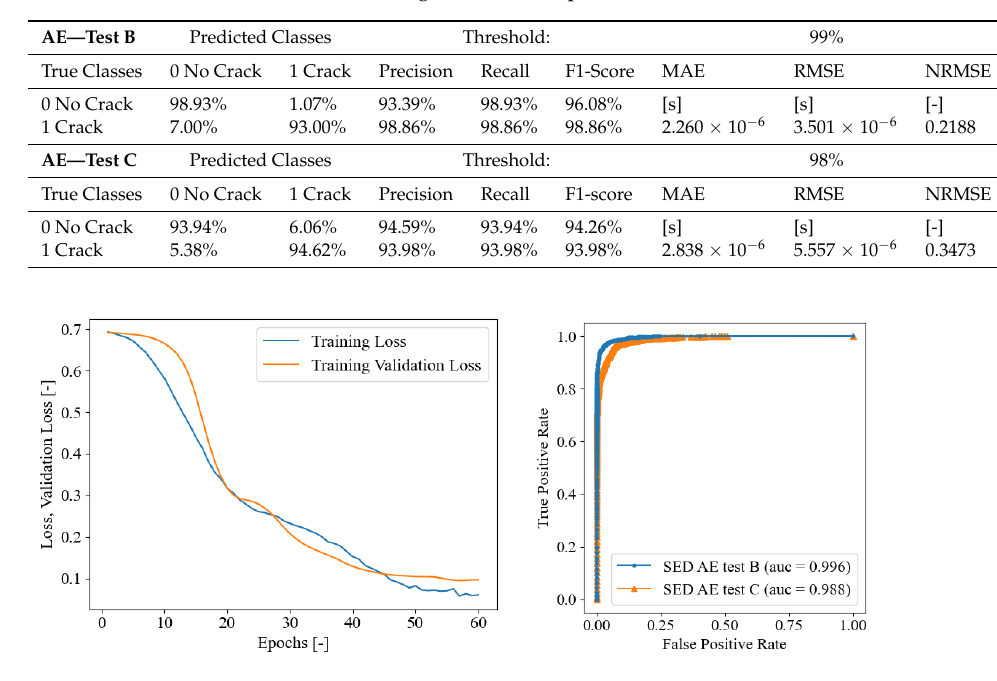
Figure 8. On the left : SED trained on AE only (training set: PLB test A), training loss convergence curves. On the right : ROC curve for AE PLB test set B and